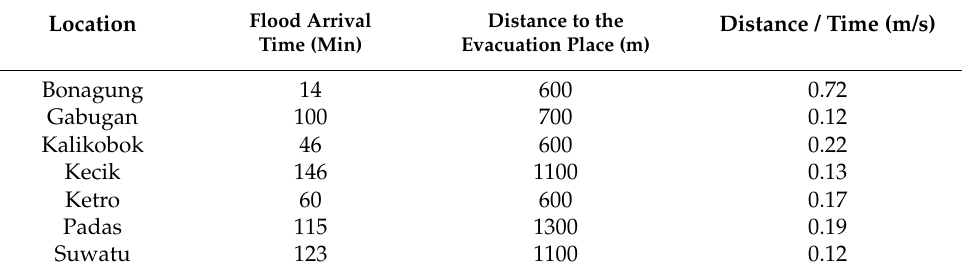
Table 7. Flood arrival time and the distance to the evacuation